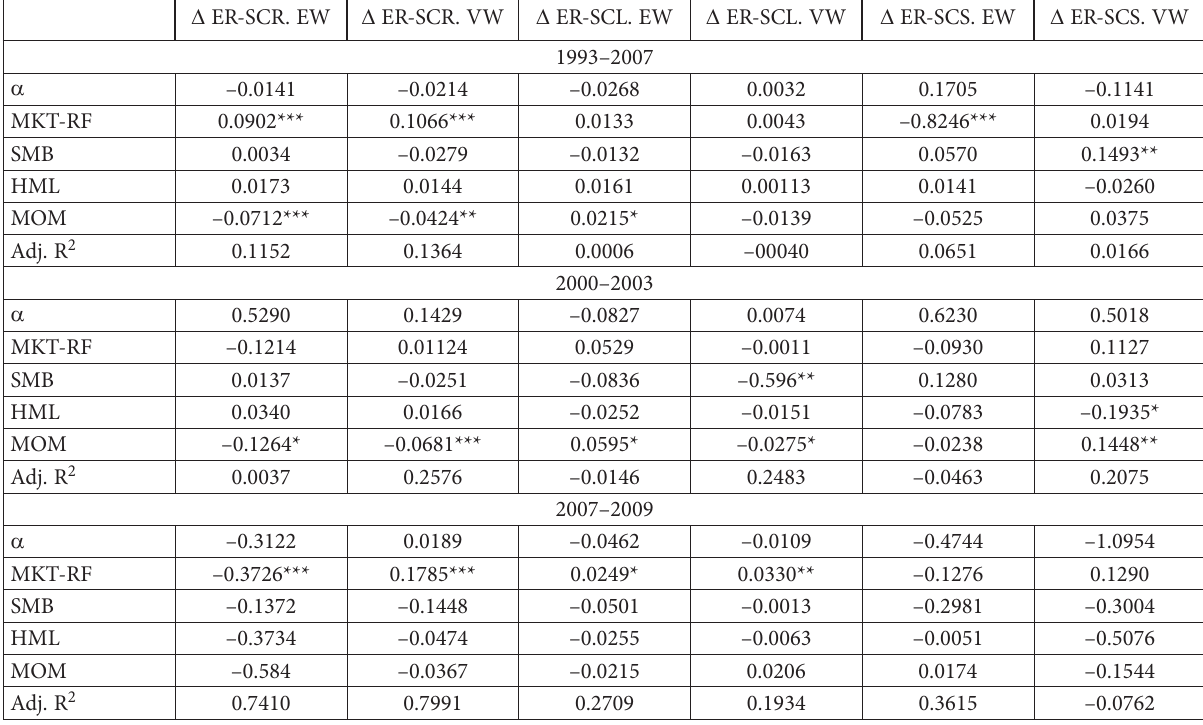
Table 6. Statistical margin of difference with Carhart four-factor